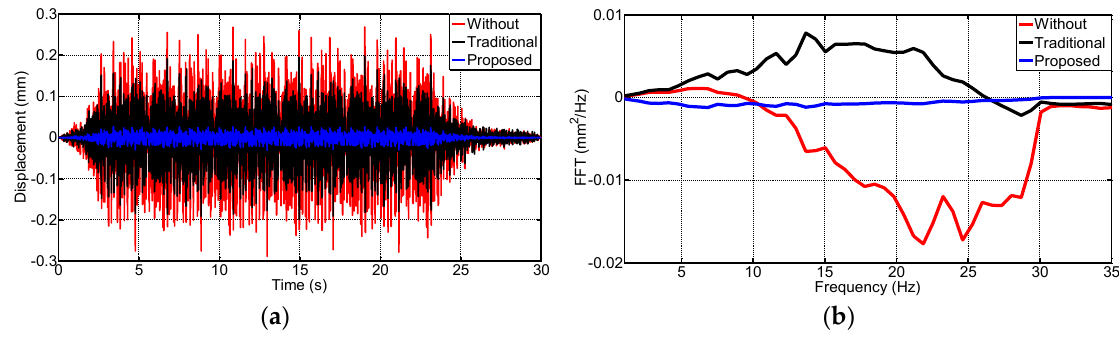
Figure 19. The reference signal. ( a ) Time domain; ( b ) Frequency domain.